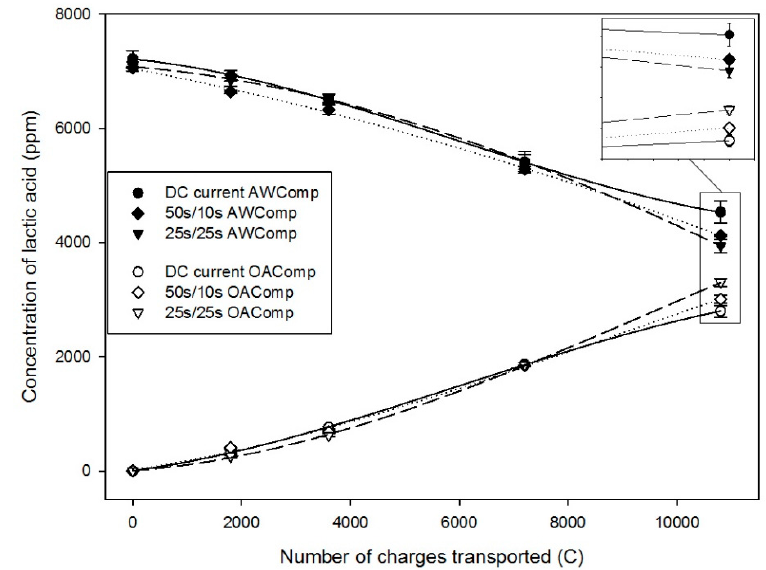
Figure 1. Evolution of lactic acid (in ppm) in the AWComp (black points) and OAComp (white points) for the DC (dots), pulsed electric field (PEF) 50 s/10 s (rhombuses), and PEF 25 s/25 s (inverted triangles) current conditions.